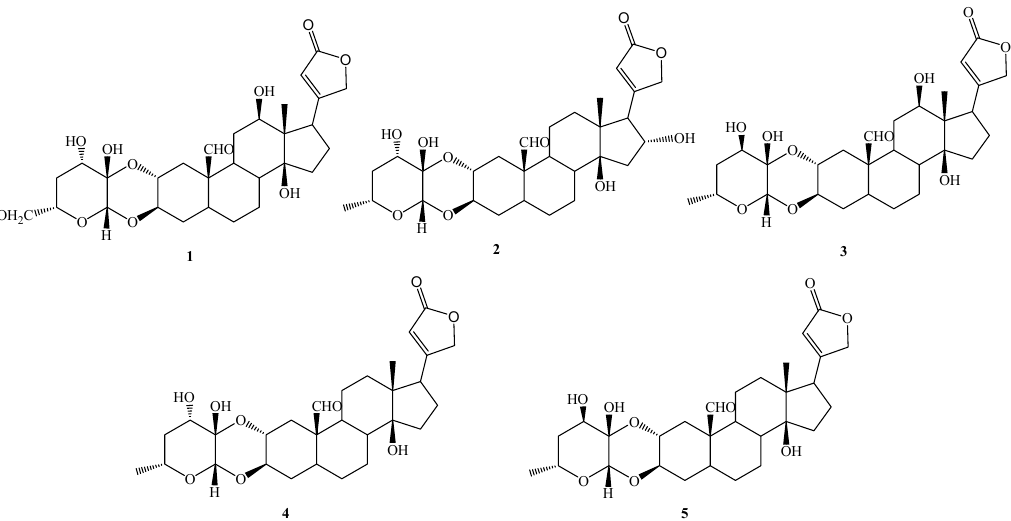
Figure 1. Cardenolides ( 1 – 5 ) isolated from the aerial parts of Pergularia tomentosa .